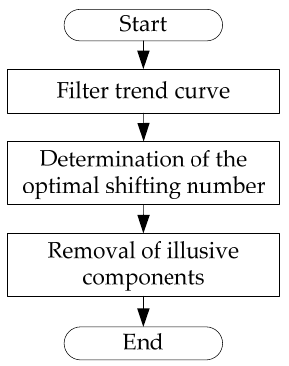
Figure 3. Analysis flow of improved Hilbert–Huang Transformation (HHT).